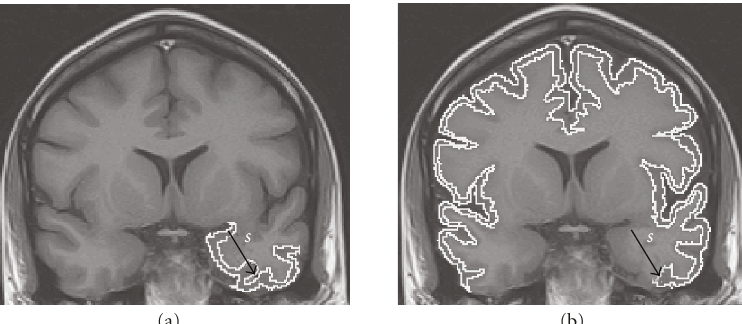
Figure 2: An MR-T1 image of the brain with one seed s inside the cortex. (a-b) The maximum influence zones of s within the cortex for f max with δ 3 and with δ 6 , respectively. The asymmetry of δ 6 favors segmentation in anticlockwise orientation, increasing the influence zone of s